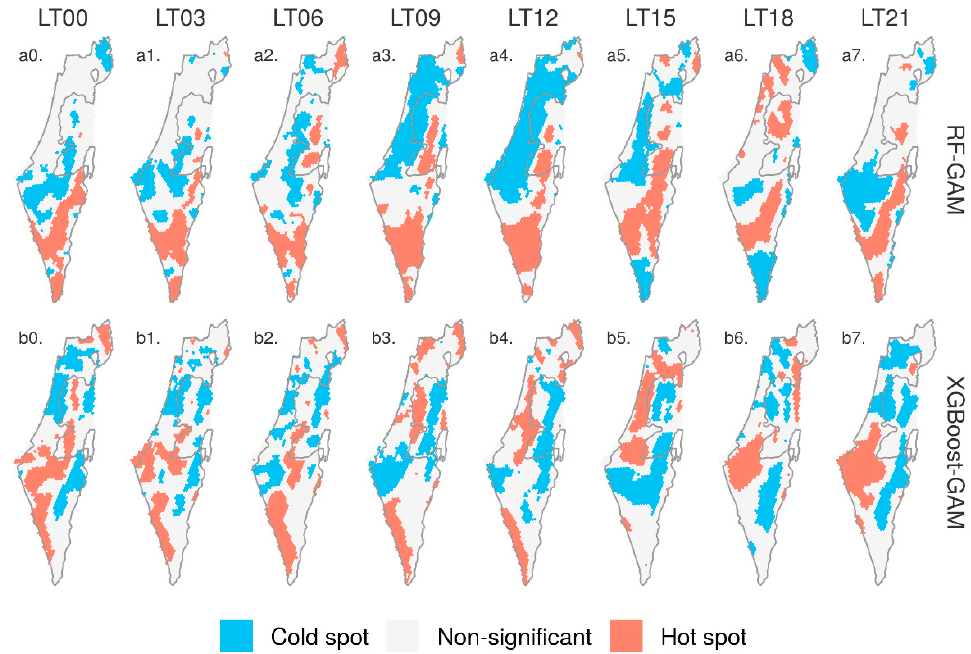
Figure 11. Spatio-temporal pattern of hot/cold spots using Gi* statistics based on the differences of estimated Ta between RF and GAM ( a0 – a7 ), and between XGBoost and GAM ( b0 – b7 ) at different local times (LT).